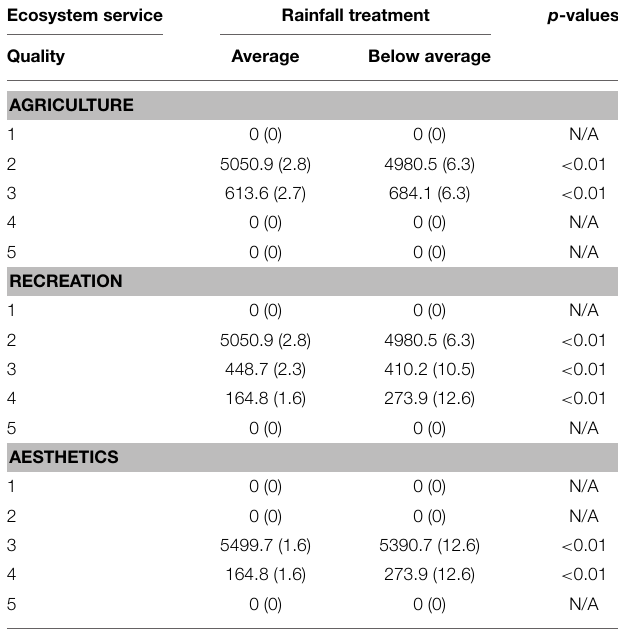
TABLE 2 | Total area (ha) of riparian vegetation classes produced in the average and below average rainfall treatment scenarios. Vegetation class